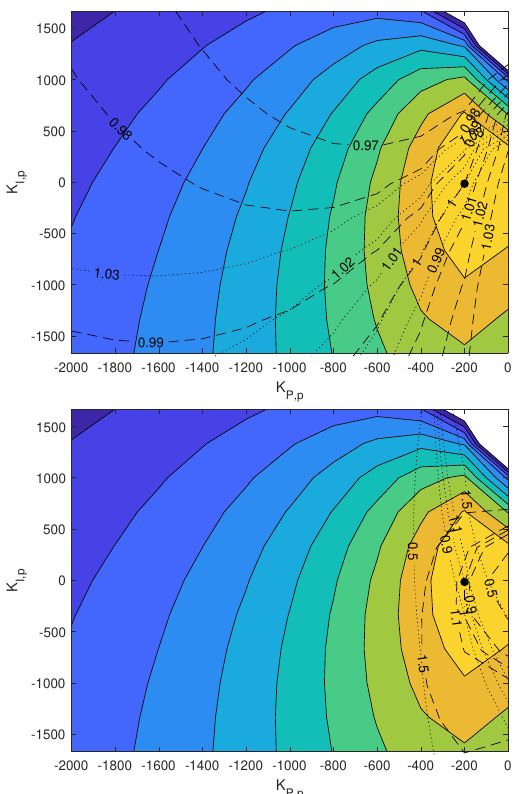
Fig. 10: Power contour of the coupled surge/pitch degree of freedom for Wave ID 10A. The contour slice is taken at the surge gain that maximizes surge- pitch power capture, so that the presented axes show variation with pitch gains. The hashed lines mark the PTO load contours and dotted lines are the fatigue damage contour for the surge DOF (top) and the pitch DOF